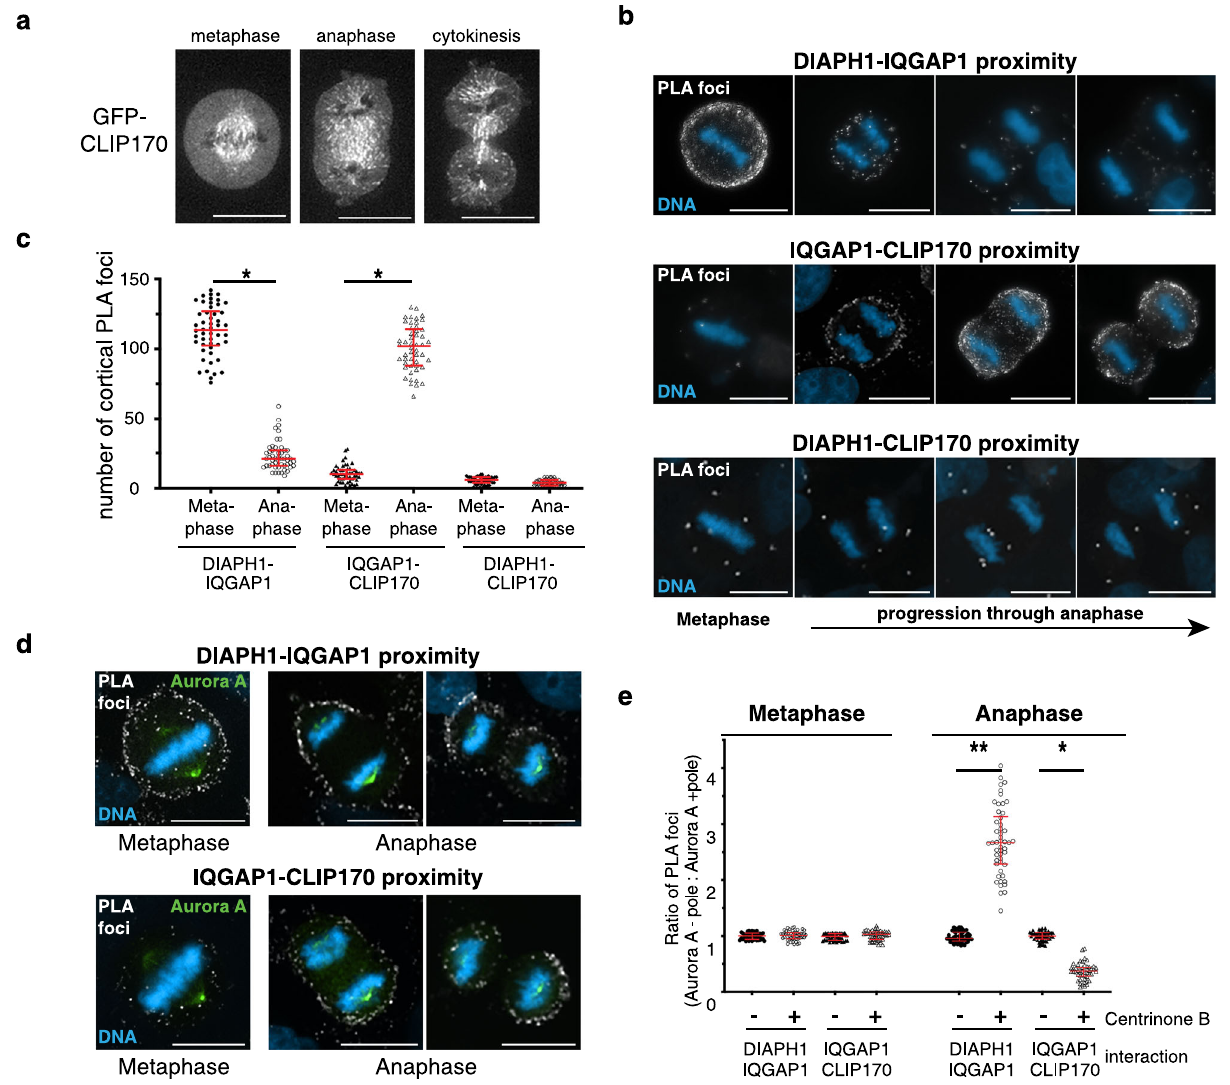
Fig. 7 The CLIP170-IQGAP1 interaction is dependent upon anaphase astral microtubules. a Time-lapse images of GFP-CLIP170 during cell division. b Proximity ligation assays (PLA) mapping the proximity DIAPH1 to IQGAP1 (top), IQGAP1 to CLIP170 (middle) and CLIP170 to DIAPH1 (bottom) during mitotic progression. c Quantitation of PLA foci in metaphase and anaphase * p < 0.0001 using a nonparametric two-tailed Mann-Whitney t -tests for three experimental repeats, n = 50 cells examined over three independent experiments. d Proximity ligation assays (PLA) mapping the proximity DIAPH1 to IQGAP1 and IQGAP1 to CLIP170 in Centrinone B-treated cells. e Quantitation of PLA foci in d . At cell poles lacking astral microtubules, DIAPH1 and IQGAP1 are in close proximity but IQGAP1 and CLIP170 are not. * p = 0.0006, ** p < 0.0001 using nonparametric two-tailed Mann-Whitney t -tests for three experimen t al repeats, n = 50 cells examined over three independent experiments. Scale bars are 10 μ